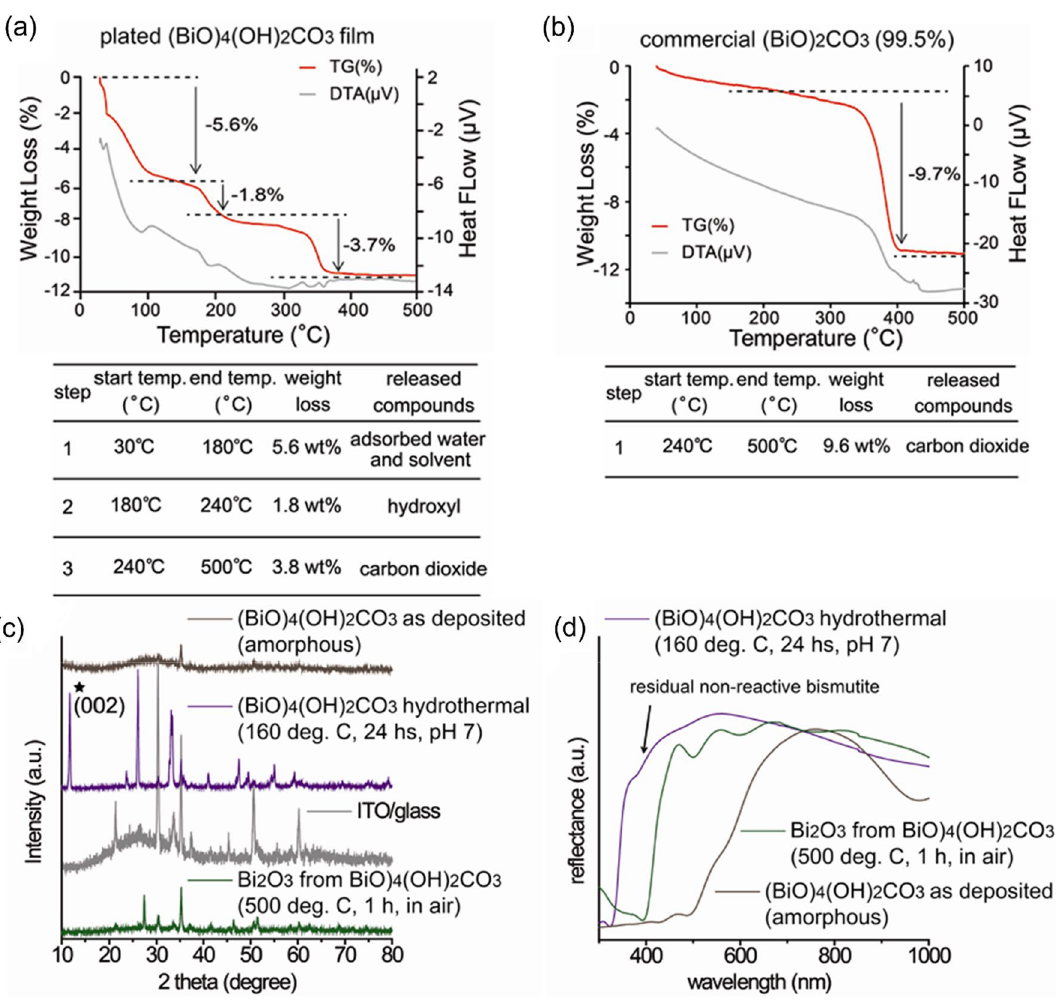
Fig. 2 a TG and DTA of a plated (BiO)